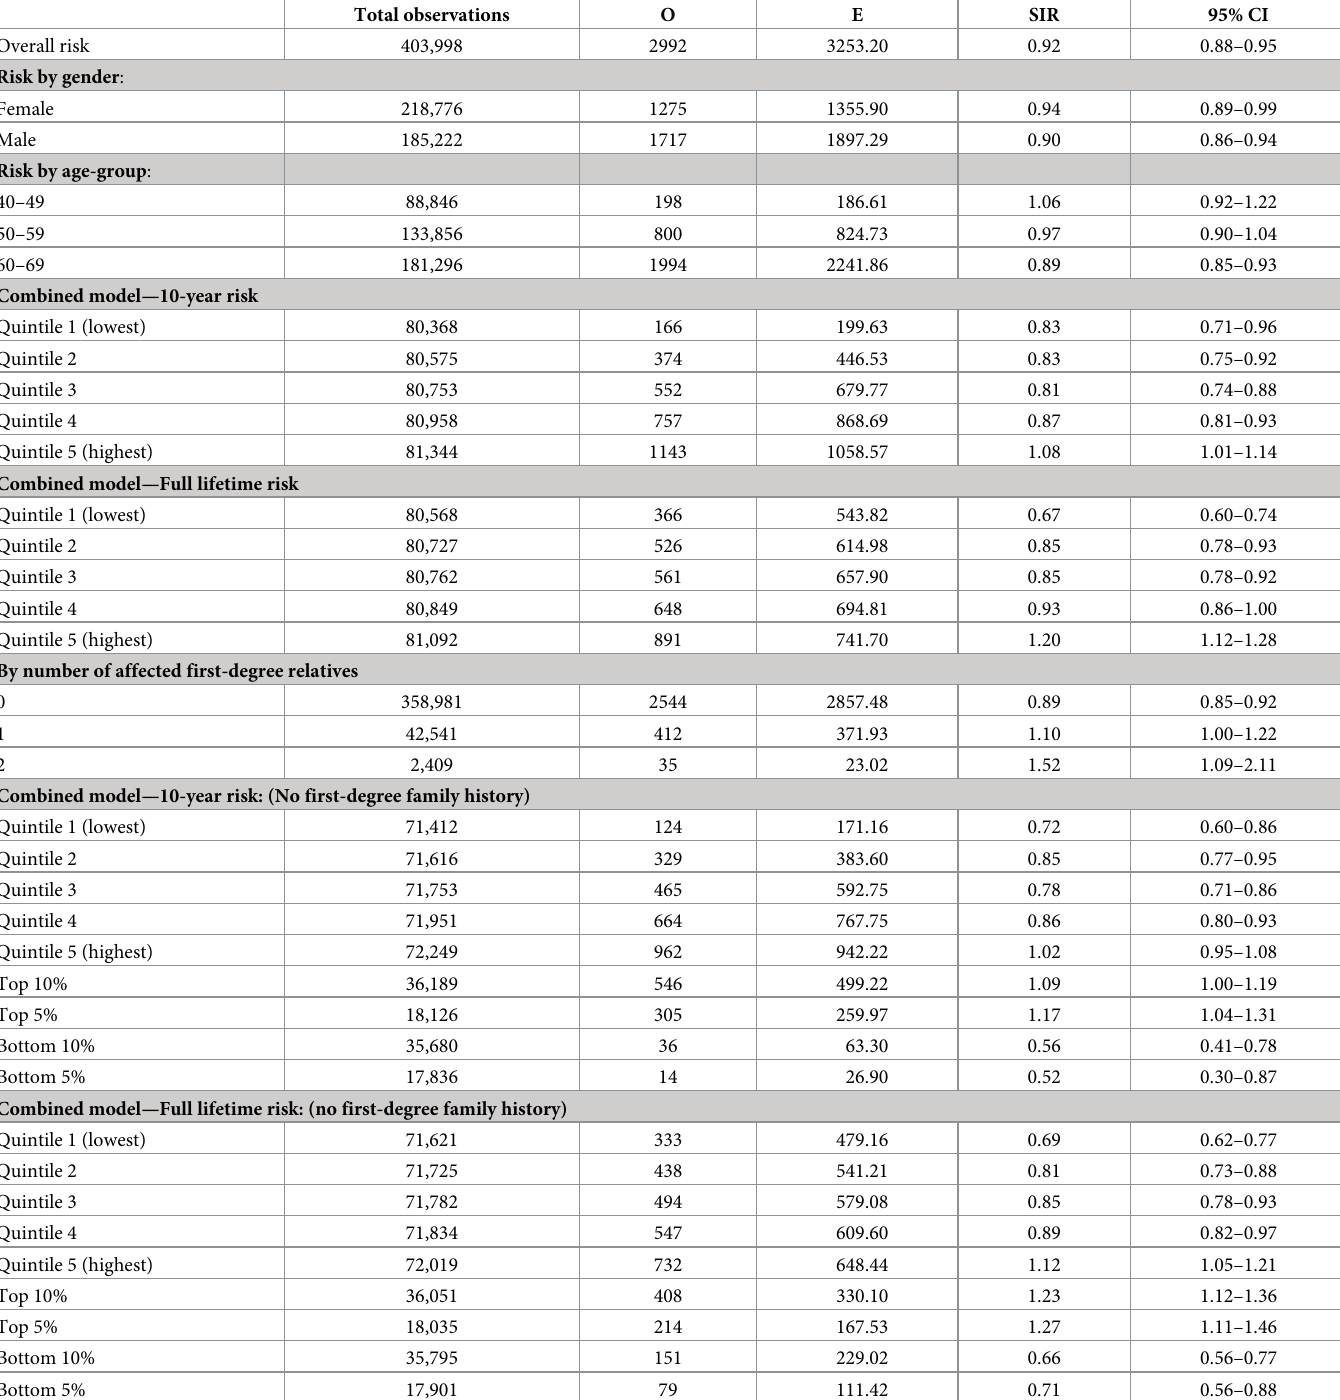
Table 3. Standardised incidence ratios (SIR) using age- and gender-specific incidence rates—Overall and by